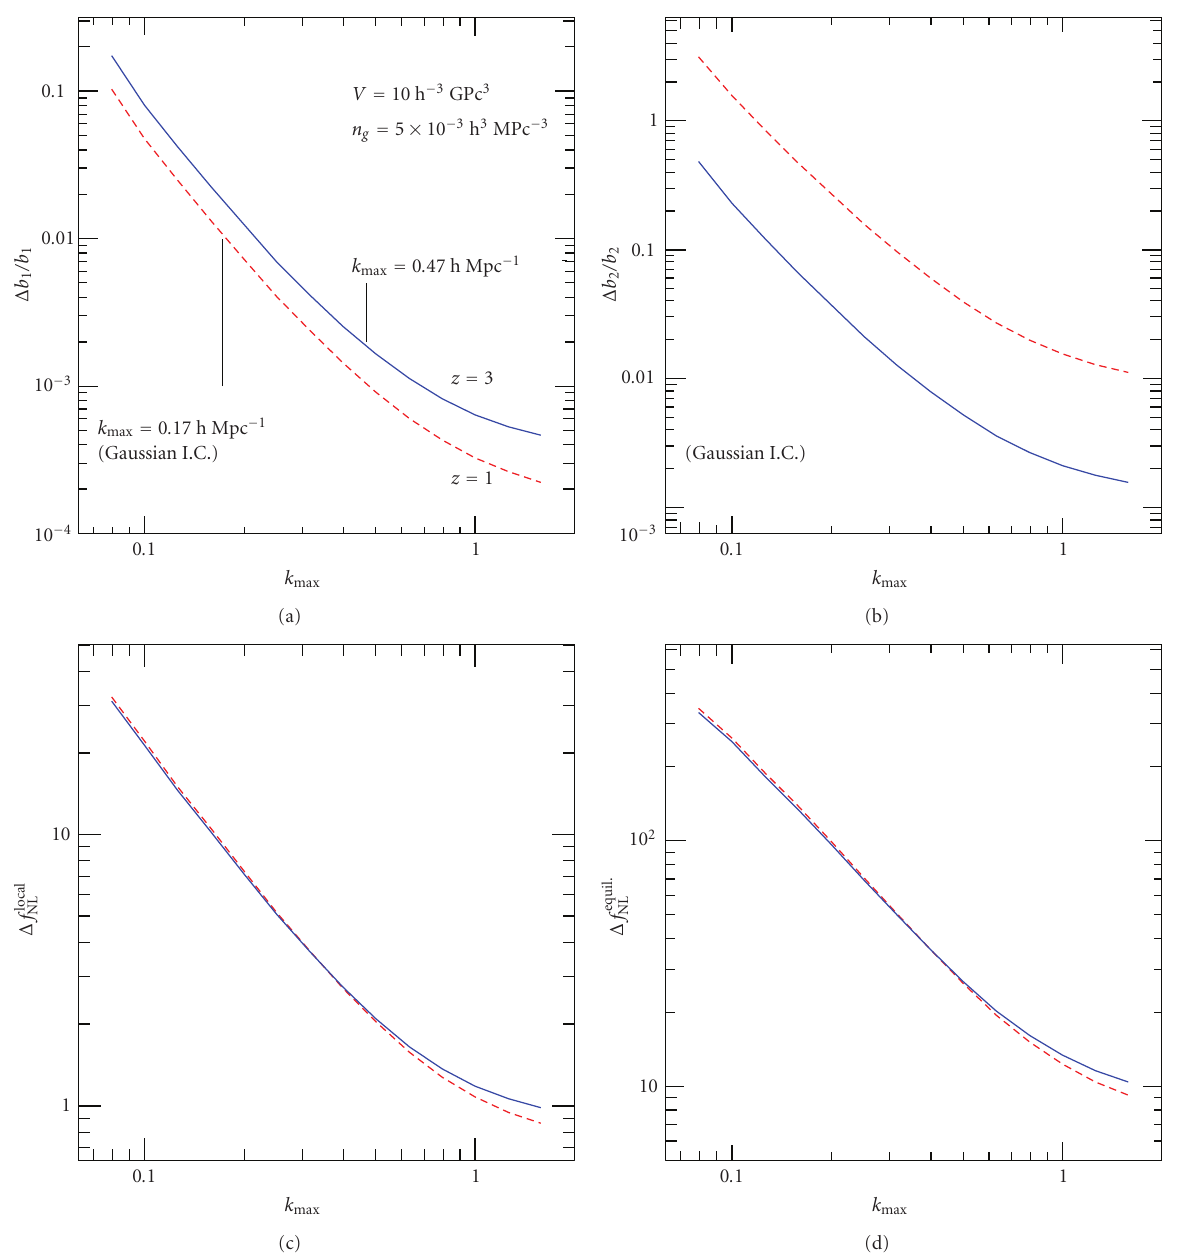
Figure 18: (a), (b) Predicted errors on galaxy bias parameters b 1 (a) and b 2 (b) as a function of the maximum wavenumber k max considered for the sum defining the Fisher matrix, (185). The analysis corresponds to an ideal geometry survey of volume V = 10h − 3 Gpc 3 and a galaxy number density of n g = 5 × 10 − 3 h 3 Mpc − 3 . Dashed (red) lines assume a mean redshift of z = 1, while continuous (blue) lines assume z = 3. Both assume that Gaussian initial conditions; that is, f NL = 0. The vertical lines correspond to the value of k max determined as the inverse of the distance scale R defined by the condition σ ( R , z ) = 0 . 5. (c), (d) Predicted errors on the non-Gaussian parameters f loc marginalized over the bias parameters, as a function of k max . The e ff ect of shot noise is evident only at very high values of k max , while for realistic surveys one can expect a more significant e ff ect at lower k . The relatively high value n g = 5 × 10 − 3 h 3 Mpc − 3 has been chosen here just for illustrative purposes, from the study by Sefusatti and Komatsu in [197].